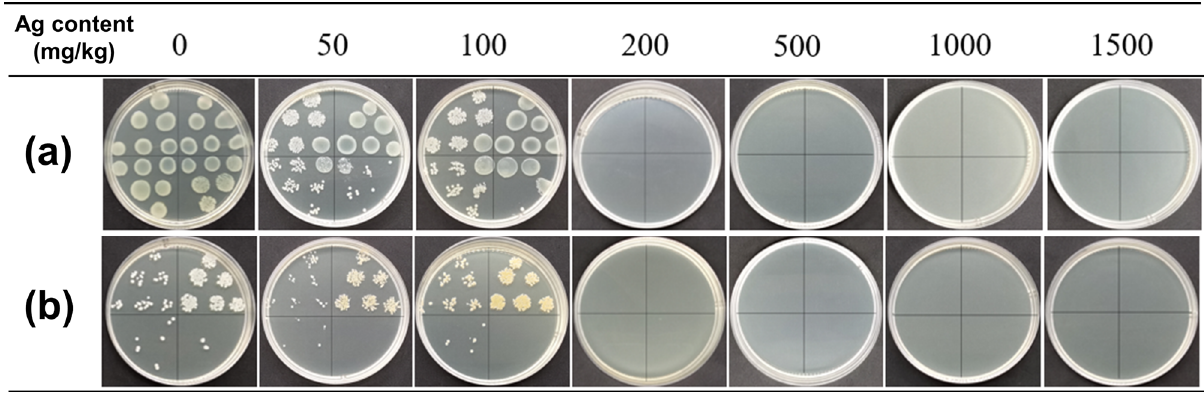
Figure 10: The antibacterial results against ( a ) Escherichia coli and ( b ) Staphylococcus aureus of the treated polyester fi bers after laundering for 50